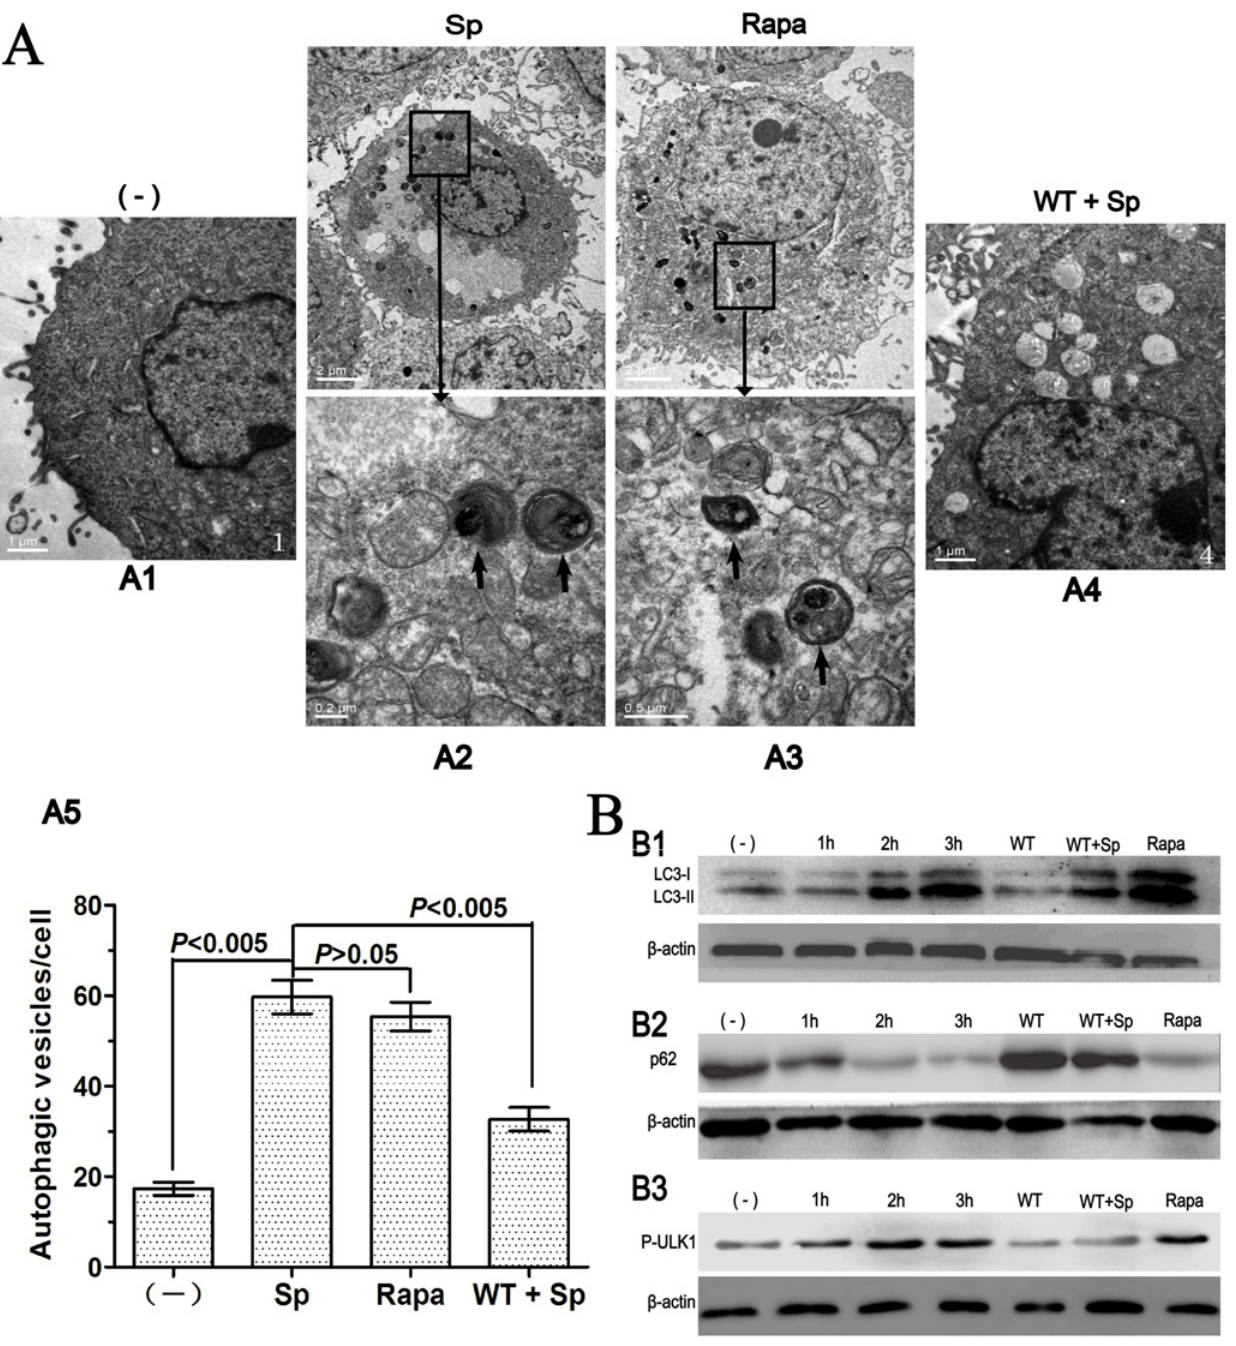
Fig 2. Sp infection induces increased autophagosome and LC3-II formation and upregulated autophagic degradation. (A) After 3 h infection, cells were processed and examined by TEM. A1. Untreated cells ( – ). A2. Cells infected with Sp (st35A). A3. Cells treated with rapamycin. A4. Cells treated with wortmannin and then infected with Sp. A5. The number of autophagic vesicles in each cell was determined with 10 cells in each sample (one-way ANOVA; Tukey ’ s posthoc test). (B) Sp infection induces LC3-II formation and upregulated autophagic degradation. B1. Western blot of LC3. B2. Western blot of P62. B3. Western blot of P-ULK1. Data are representative of three experiments with similar results. Sp: S . pneumoniae ; Rapa: rapamycin; WT: wortmannin; p62: Sequestosome 1; p-ULK1: phosphorylated UNC-51-like kinase 1.